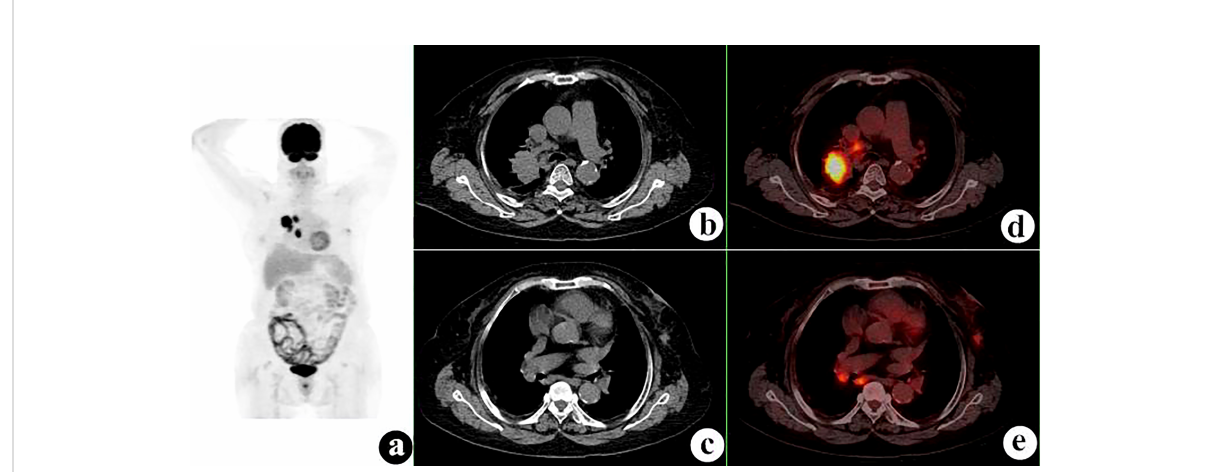
FIGURE 6 18 F- fl uorodeoxyglucose positron emission tomography/computed tomography ( 18 F-FDG PET/CT) of a 78-year-old woman with lung squamous cell carcinoma, synchronous left breast ductal carcinoma, and lymph node metastases. PET/CT demonstrated a 32 × 45-mm mass with a maximum standardized uptake value (SUV max ) of 12.2 in the right upper lobe, a 15 × 9-mm nodule with SUV max = 2.6 in the left breast, and several mediastinal lymph nodes with SUV max = 10.2. (A) PET maximum intensity projection (MIP). (B, C) Axial CT. (D, E) Fusion